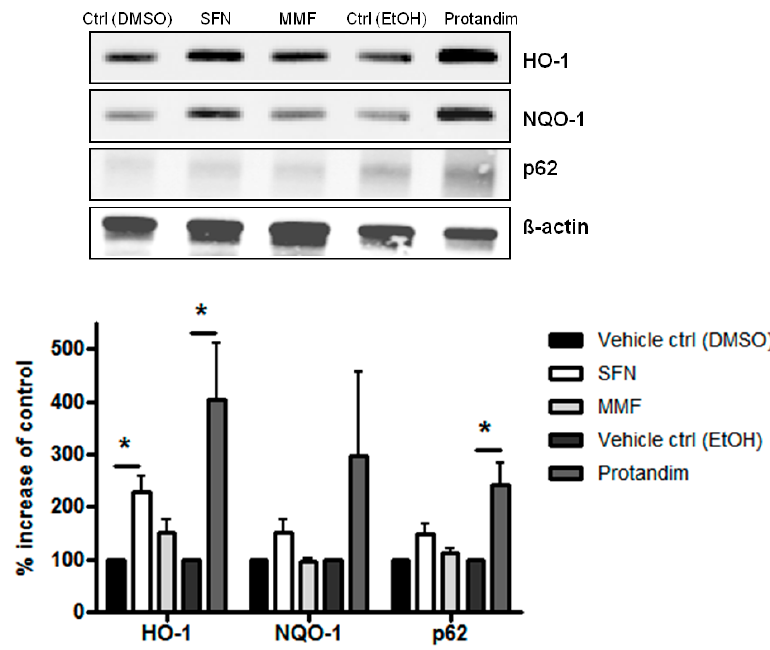
Figure 3. Nrf2-activators dose-dependently increase antioxidant protein expression in mature primary rat OLs. HO-1, NQO-1 and p62 protein expression levels after 24 h treatment in mature primary rat OLs, differentiated for 7 days, with 5 µ M SFN, 90 µ M MMF,30 µ g/mL Protandim or their respective DMSO or EtOH vehicle control. Protein levels were assayed by Western blotting. Data are presented as percentage of control and expressed as the mean ± SEM of 3 independent experiments. Statistics reflect one-way ANOVA test with post hoc Bonferroni correction; * p <